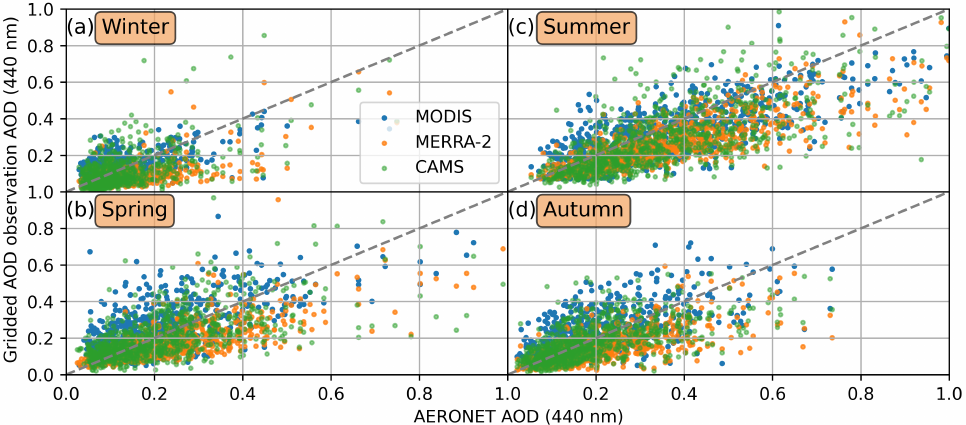
Figure 6. Comparisons of AOD 440 between AERONET and MODIS (blue dots), MERRA-2 (orange dots) or CAMS (green dots) over Saada for ( a ) winter, ( b ) spring, ( c ) summer and ( d ) autumn. The 1:1 line is represented by the dashed